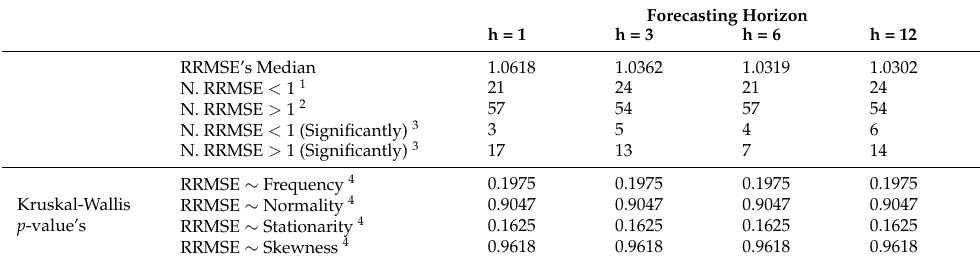
Table 2. RRMSEs’ descriptives and Krskal-Wallis test results.